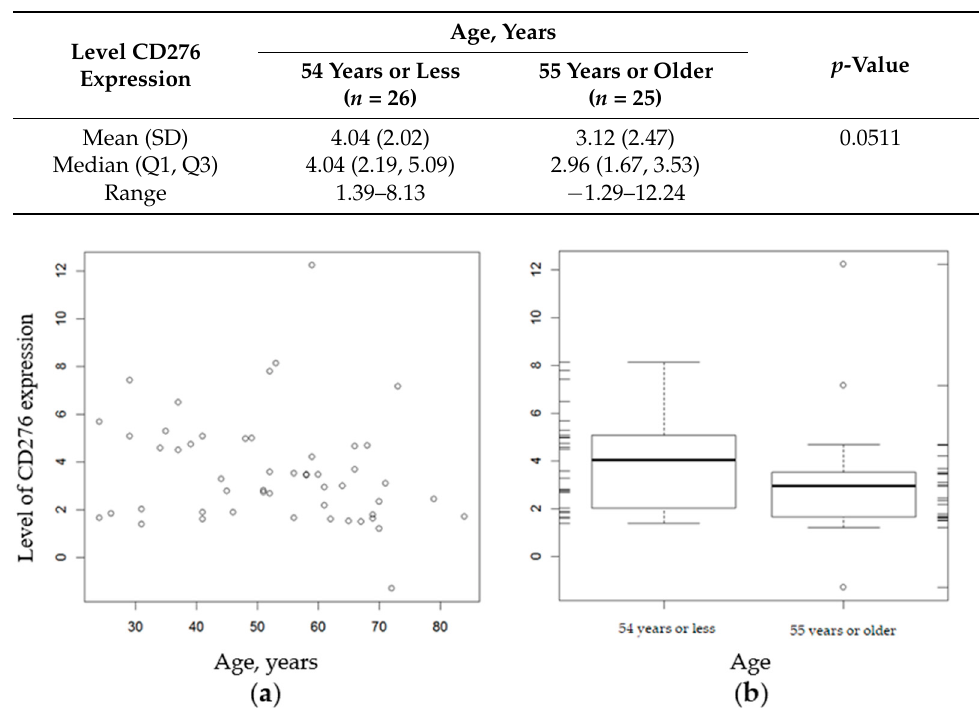
Table 6. Relationship between CD276 expression and age.